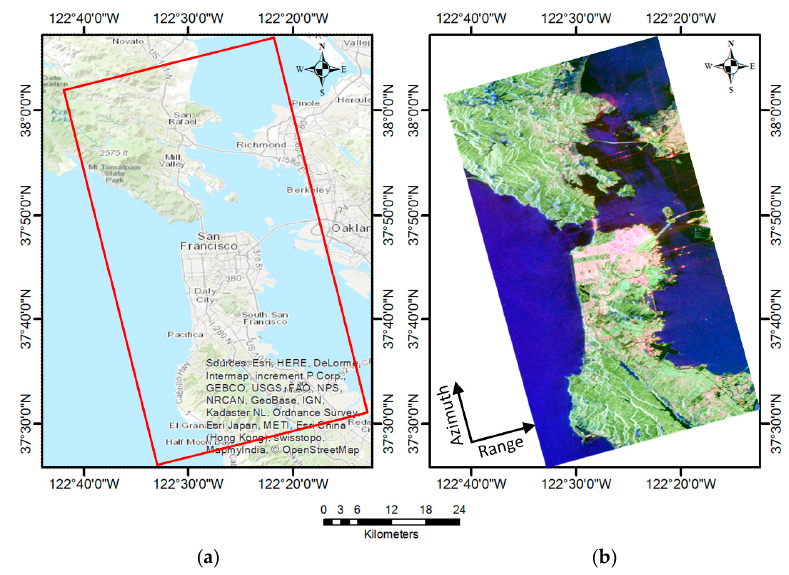
Figure 2. Study area and the PolSAR image acquired with the Phased Array type L-band Synthetic Aperture Radar (PALSAR) system: ( a ) San Francisco map, where the red rectangle indicates the imaging area; and ( b ) PolSAR image with Pauli color-coding (Red: |HH − VV|, Green: |HV|, Blue: |HH+VV|). Table 1. Acquisition information about the Phased Array type L-band Synthetic Aperture Radar (PALSAR) data.